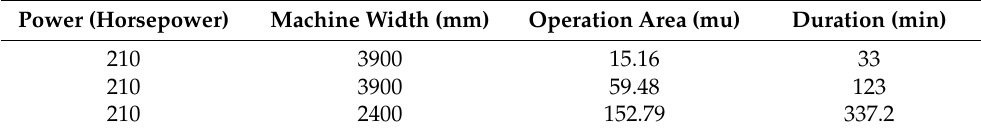
Table 1. Effect of Different Operation Duration of Agricultural Machinery with the Same Power. Power (Horsepower)